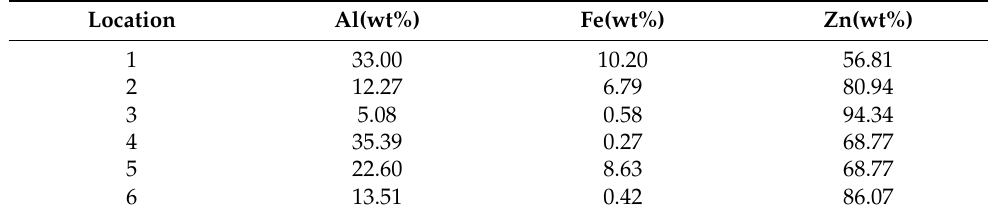
Figure 3. The morphology and energy spectrum analysis of 450-45-W hot dip plating layer under SEM, ( a ) cross-sectional morphology of hot dip plating layer; ( b ) morphology of hot dip plating layer and corresponding micro-area energy spectrum analysis. Table 6. Point scan and surface scan results of 450-45-W hot dip plating.